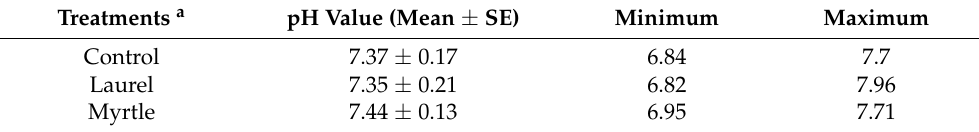
Table 3. The effect of laurel and myrtle EOs on the pH value of the intestinal contents in rats. Treatments a